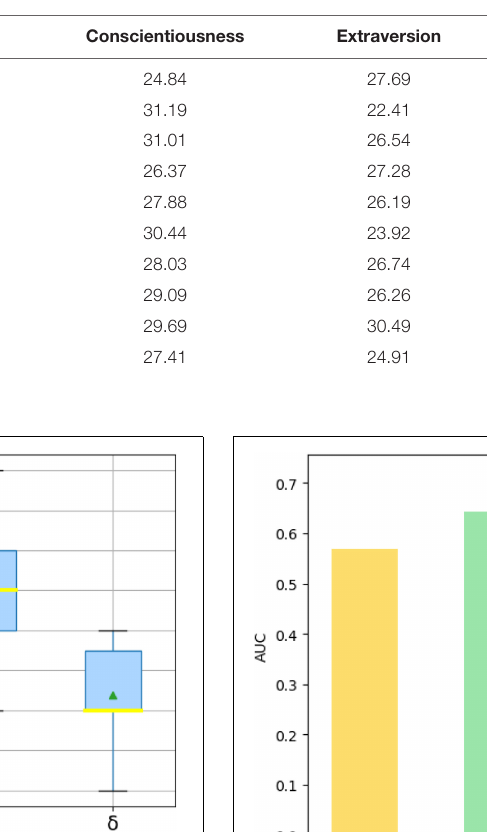
TABLE 7 | A link preference of personality traits.